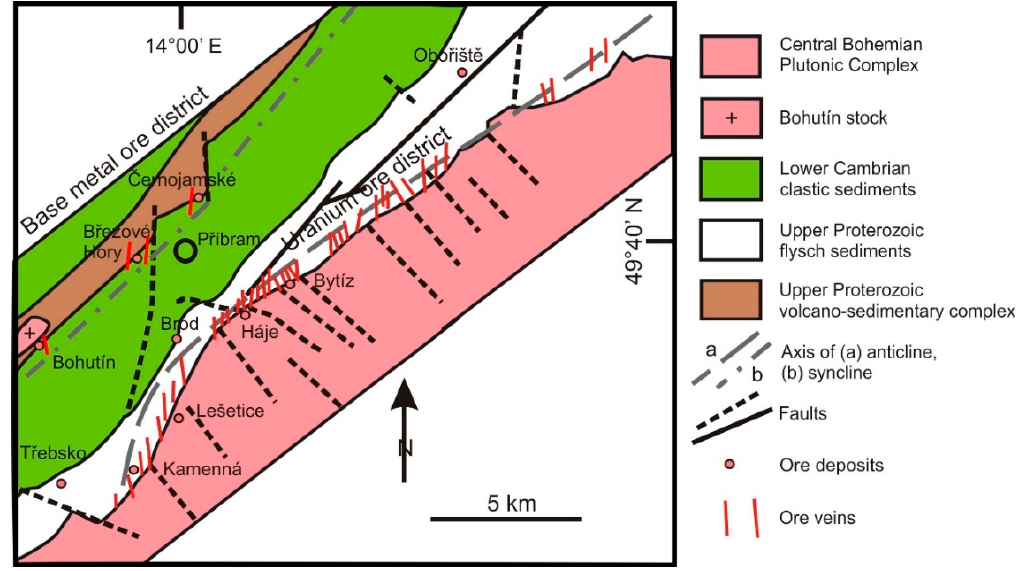
Figure 2. Schematic geological map of the P ř íbram base metal and uranium ore districts (modified from K ř íbek et al. [17]).